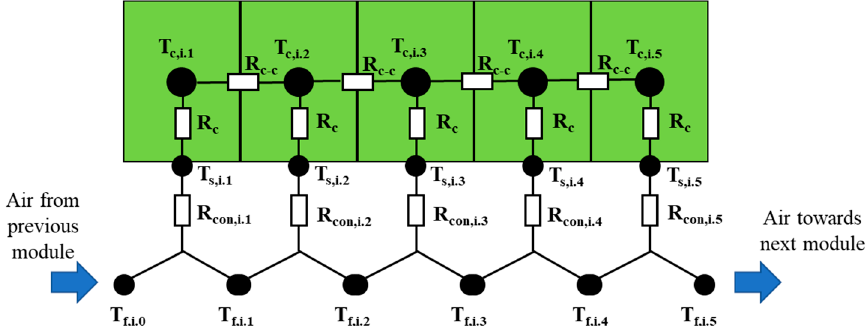
Figure 10. Mathematical model of a cell’s transversal section.